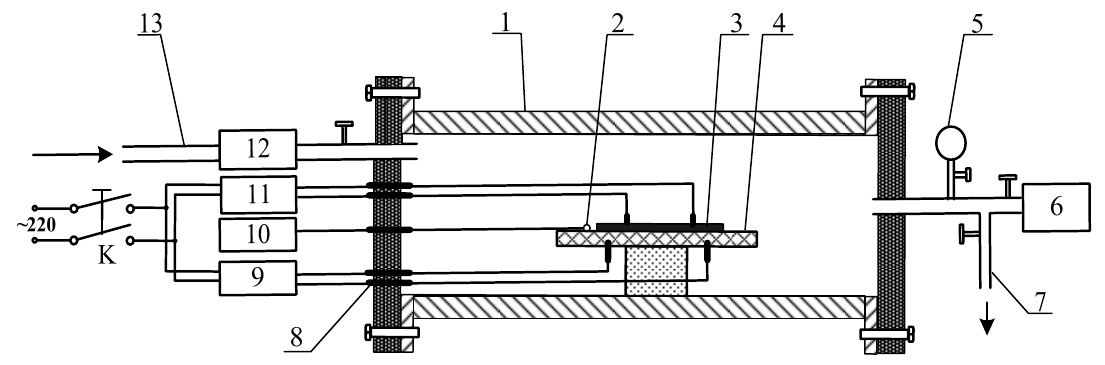
Figure 2. Detection test device for the TiO of SF decomposition 6